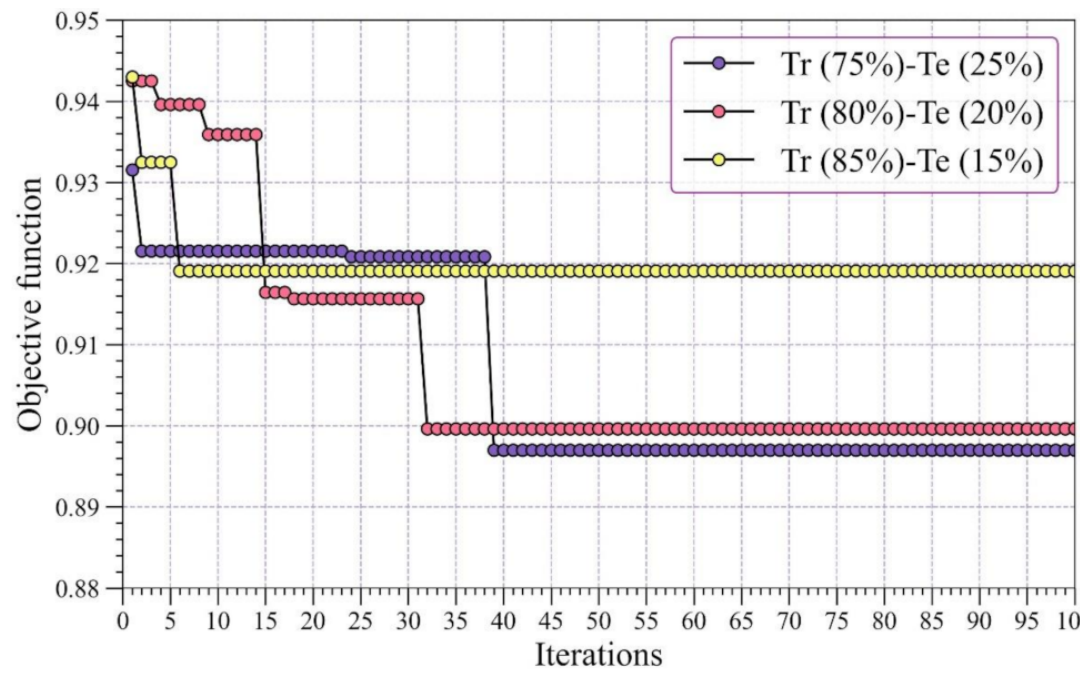
Figure 8. Convergence of objective function during BO.